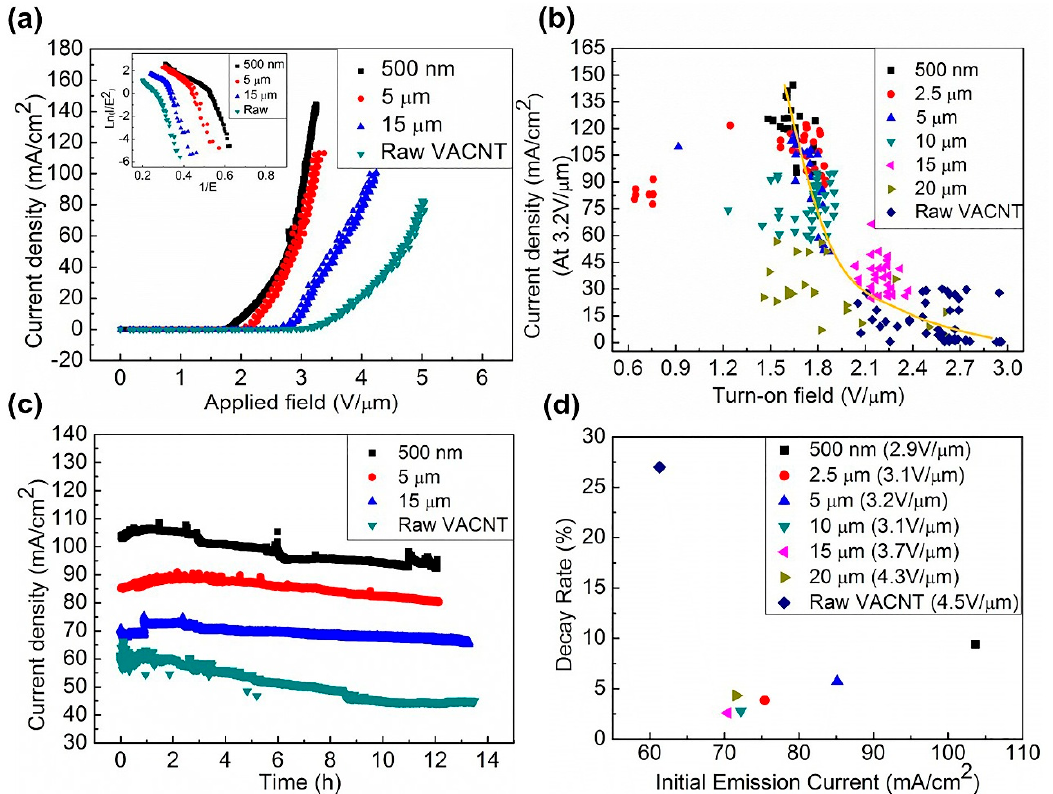
Figure 4. ( a ) Current density–applied field curves of the raw VACNT film; the cone arrays of the tip size are about 500 nm, 5 µ m, and 15 µ m, and the illustration is Forwer–Nordheim plots. ( b ) The statistical diagram of the relationship between the open field strength and the current density of the unprocessed samples and the cone array samples with different tip sizes. ( c ) Current–time stability curves of the raw VACNT film; the cone arrays of the tip size are 500 nm, 5 µ m, and 15 µ m. ( d ) The relationship between the current decay rate (12 h) and the initial current of raw samples and cone array samples with different tip sizes was studied. (The calculated emission is 4 mm 2 from ( a – d